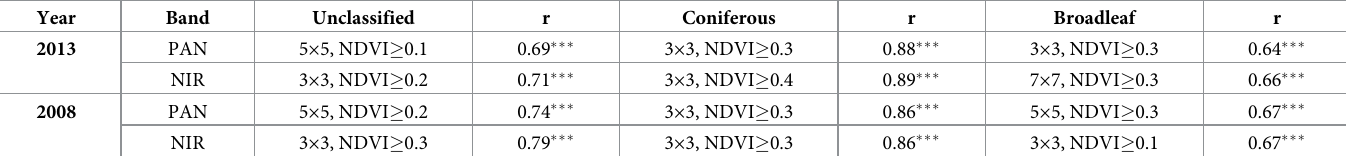
Table 1. Comparison result of stand density between two QuickBird images used in different forest from the Jiufeng